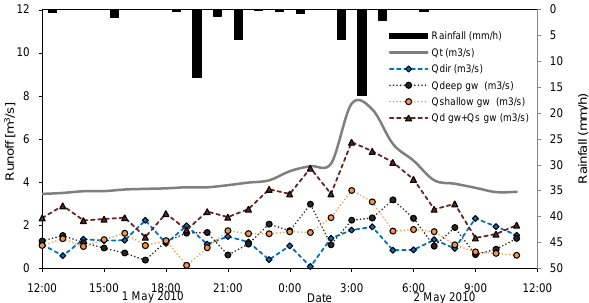
Figure 7 Results of the three-component separation using dissolved silica and deuterium as tracers for Fig. 7. Results of the three-component separation using dissolved event K6 (see Fig. 2a) investigated from 1 May 2010 at 12:00 to 2 May 2010 at 11:00 at Kansi station. Q dgw silica and deuterium as tracers for event K6 (see Fig. 2a) investi- + Q sgw is the sum of deep and shallow groundwater components. gated from 1 May 2010 at 12:00 to 2 May 2010 at 11:00 at Kansi station. Q dgw + Q sgw is the sum of deep and shallow groundwater components.